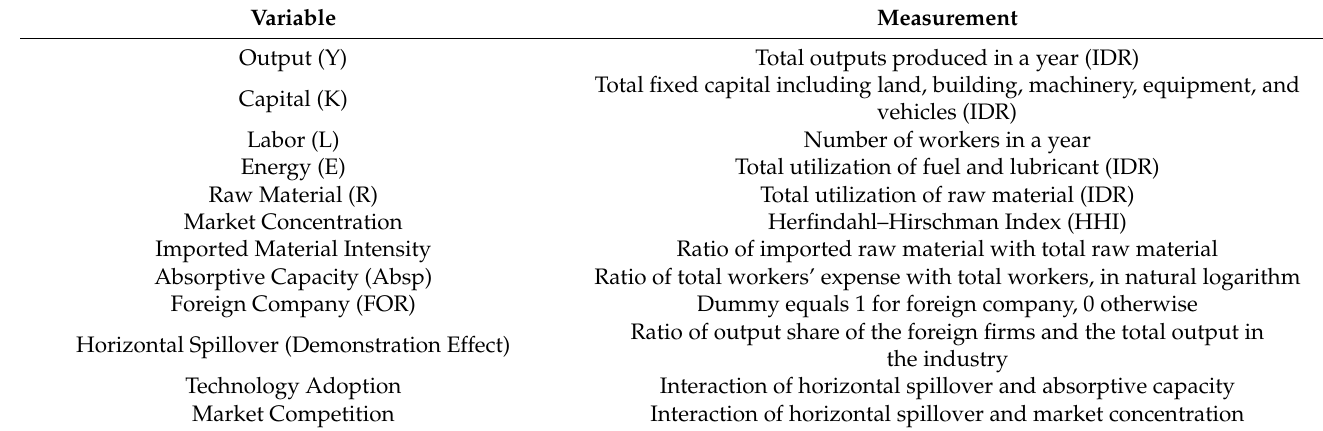
Table 1. Employed